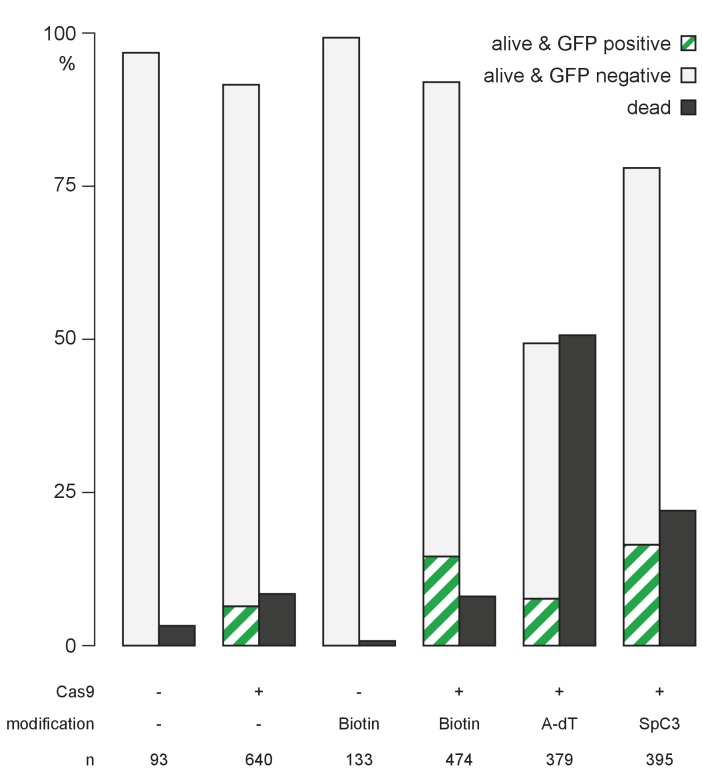
Quantification of survival and GFP expression of injected embryos.Embryos injected with unmodified or 5’Biotin, Amino-dT or Spacer C3 modified long dsDNA gfp-rx2 donor cassettes were scored for survival at one dpi, and for GFP expression at two dpi. n, total number of injected embryos.10.7554/eLife.39468.007Figure 2—figure supplement 1—source data 1.Quantification of survival and GFP expression of injected embryos.